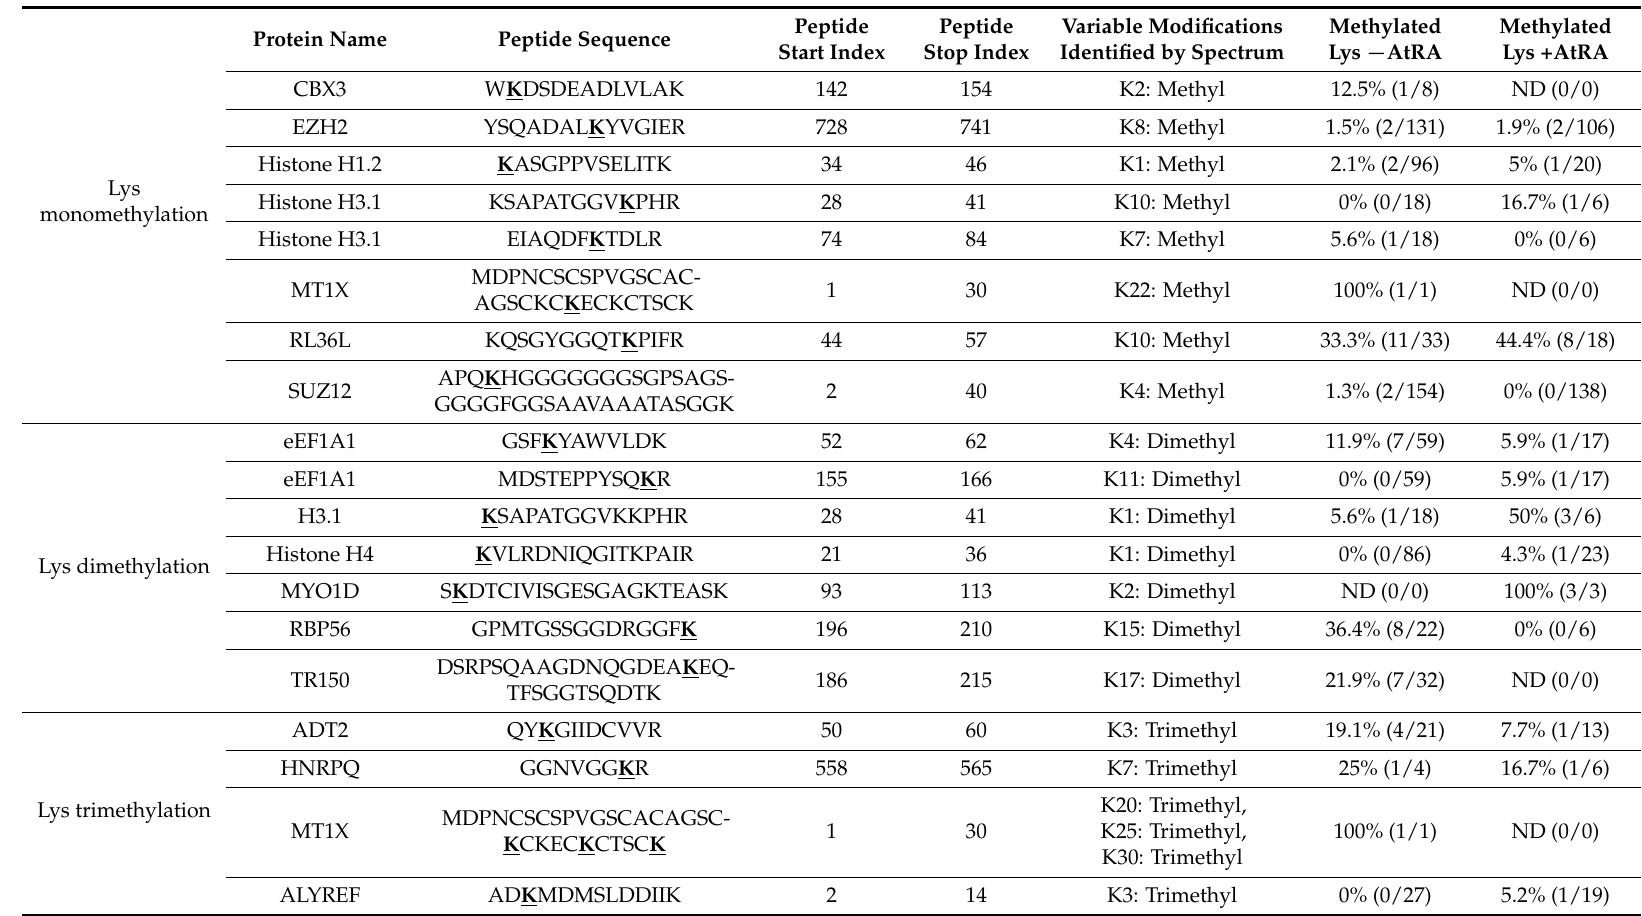
Table 3. EZH2 interactome lysine methylation